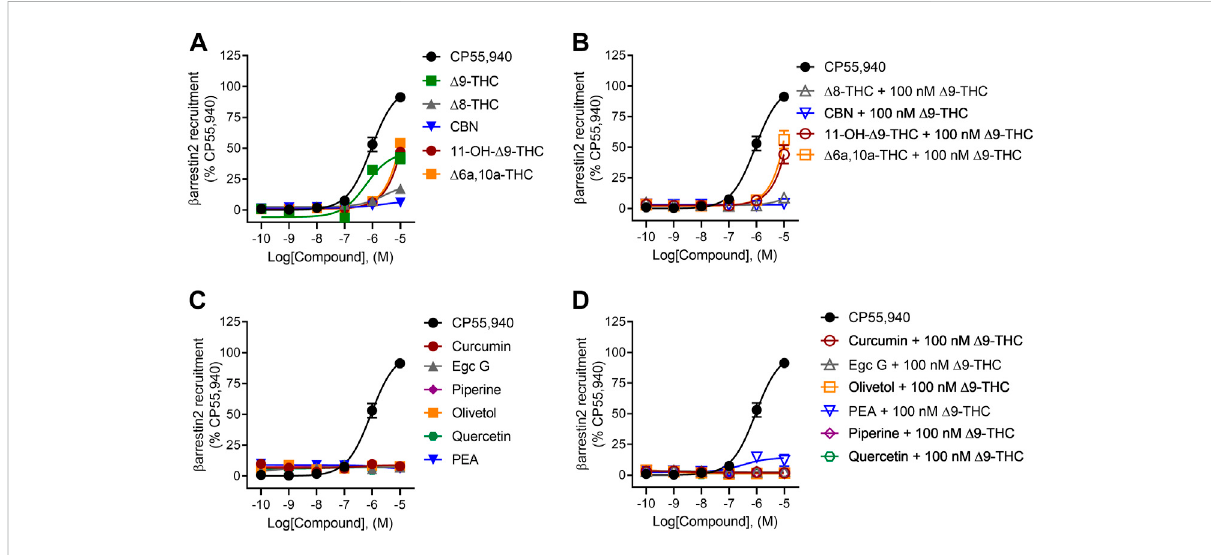
FIGURE 4 hCB1R-dependent recruitment of β arrestin2. Compound activity was quanti fi ed for β arrestin2 recruitment in CHO cells stably expressing hCB1R and treated with 0.1 nM — 10 μ M (A) cannabinoids; (B) cannabinoids + 100 nM Δ 9 -THC; (C) phytomolecules; and (D) phytomolecules + 100 nM Δ 9 -THC for 90 min according to the standard operating procedures of the PathHunter assay. Data were fi t to a variable slope (four parameters) non-linear regression in GraphPad (v. 9). n ≥ 6 independent experiments were performed in triplicate. Data are expressed as mean ± SEM. EC 50 and E max are reported in Table 1.